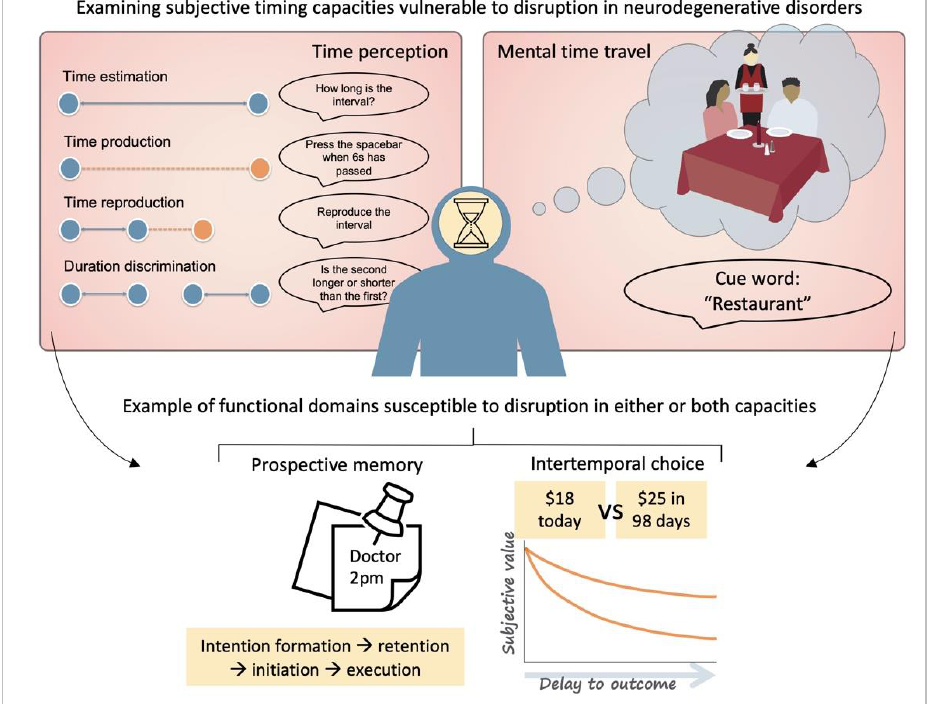
Figure 1. Mechanisms of subjective time disruption in dementia span time perception and mental time travel capacities. Many essential functional domains rely on both capacities, such as prospec- tive memory (remembering to perform an intention) and intertemporal choice (making decisions with outcomes that play out over time). Public domain restaurant image from